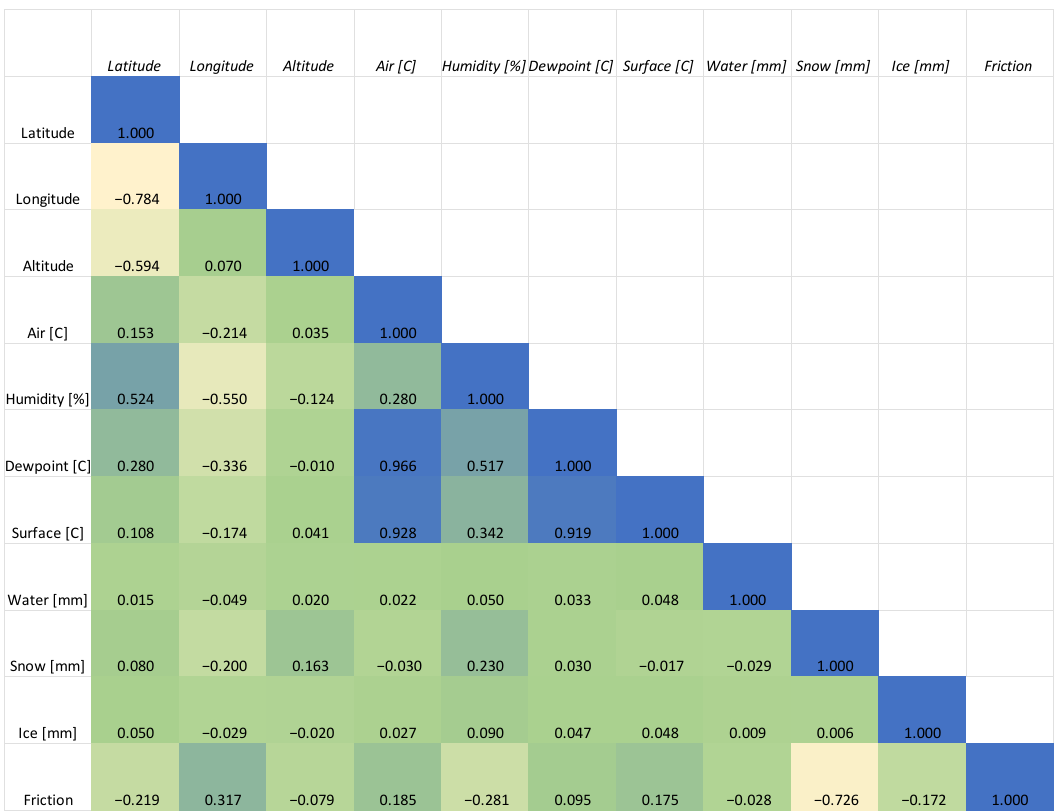
Figure 4. Correlation matrix of the potential predictors.